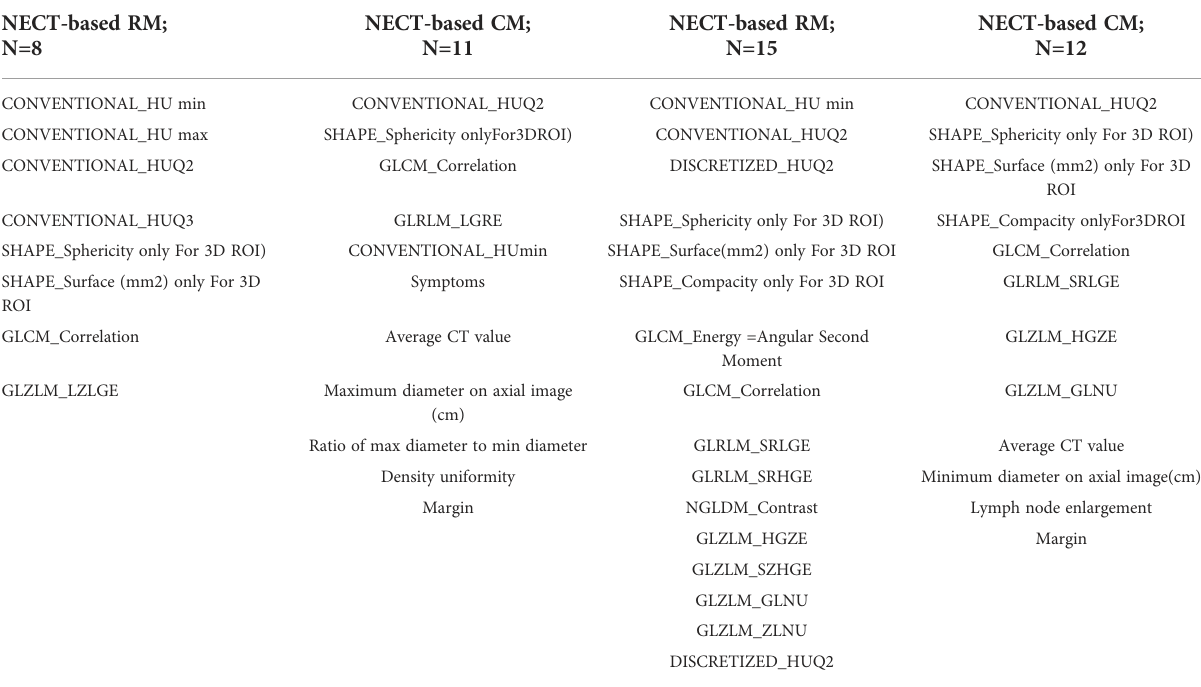
TABLE 6 Features selected by the GBDT in the two groups. Group 1: AMCs to thymomas Group 2: Low-risk to high-risk